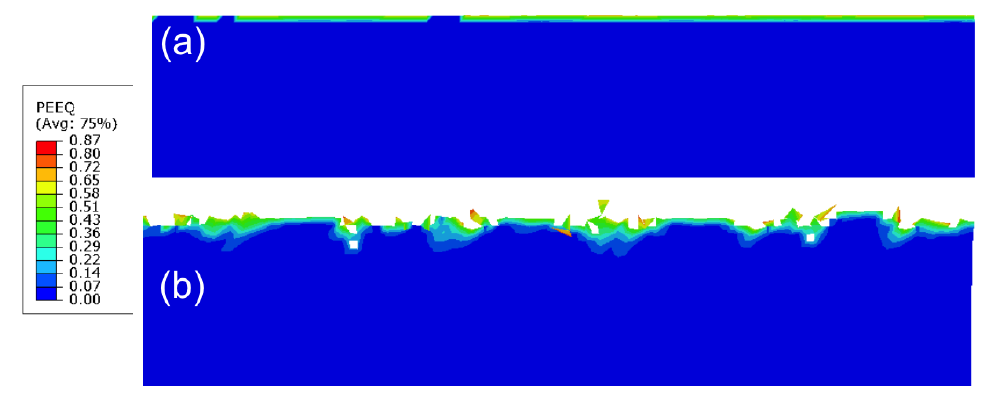
Figure 11. Surface morphology obtained from FE simulations with a fixed depth of cut of 20 nm ( a ) and 30 nm ( b ), for a rake angle of − 15 ◦ . The color code represents the equivalent plastic strain as given in the